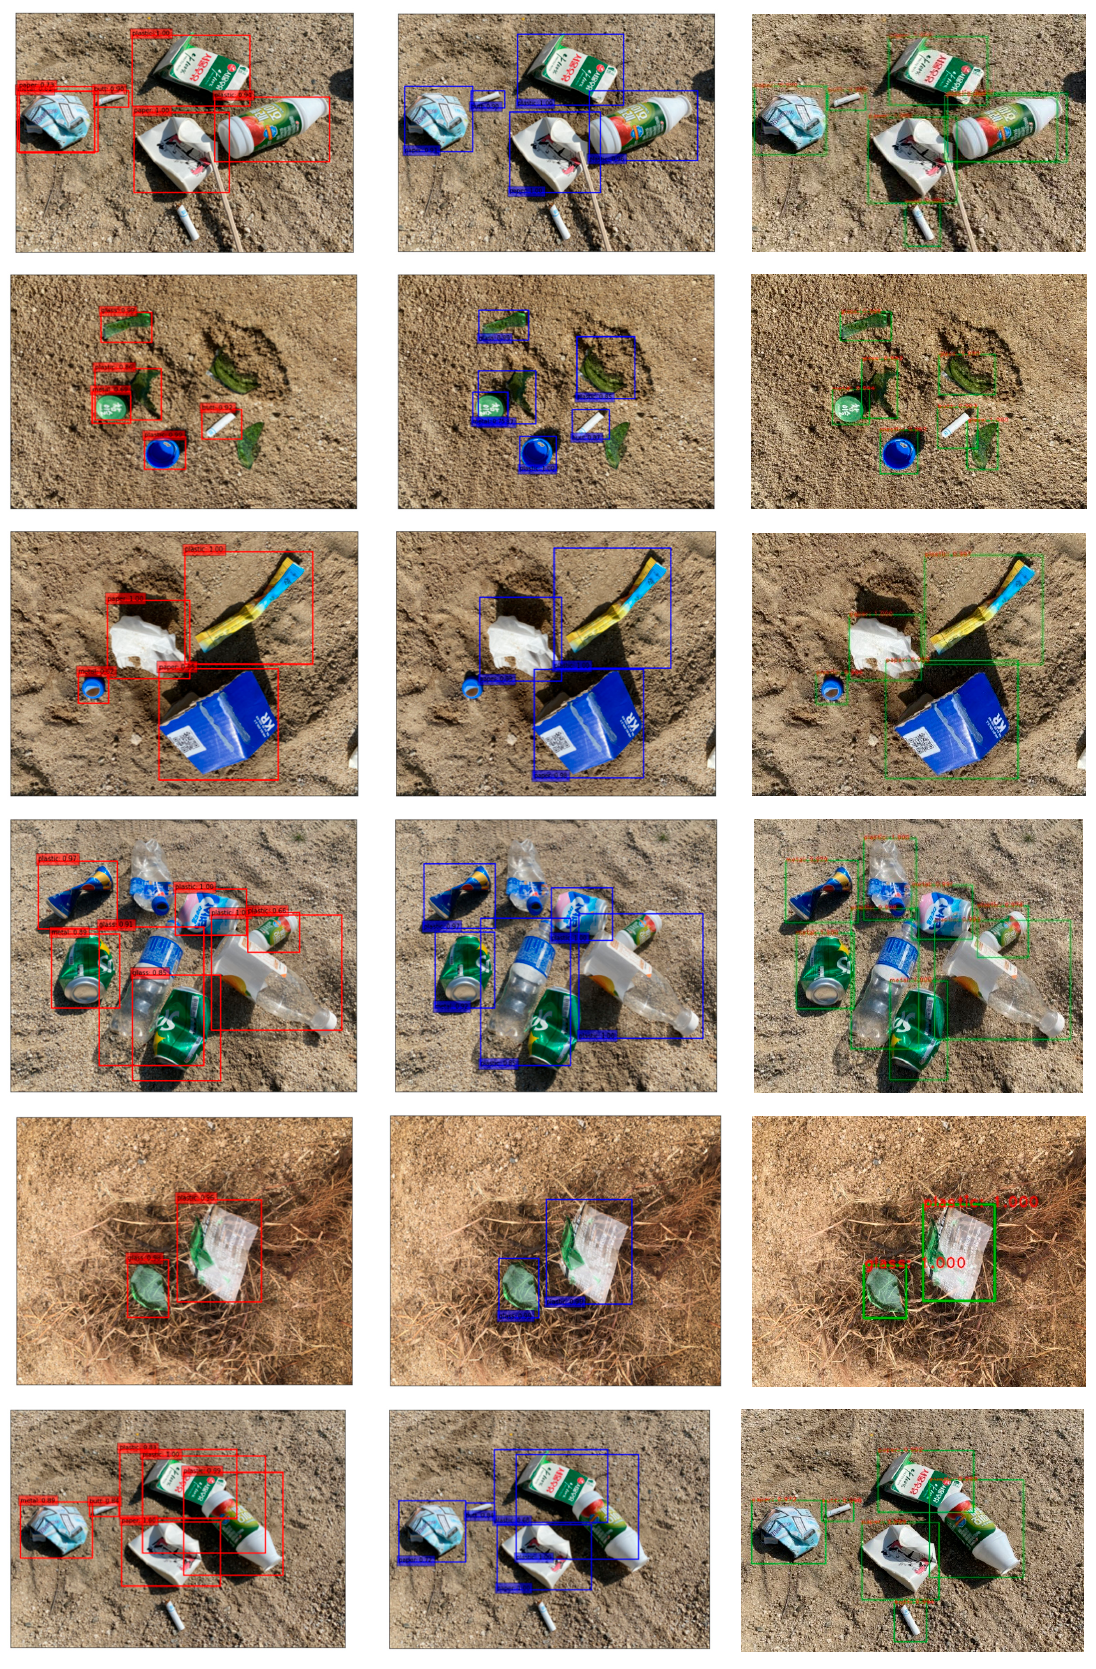
Figure 9. IST-Waste-V2 test detection results (red detection boxes on the left show SSD321 detection results, blue boxes in the middle show DSSD321 detection results, and green detection boxes on the right show MS-DSSD321 detection results) .